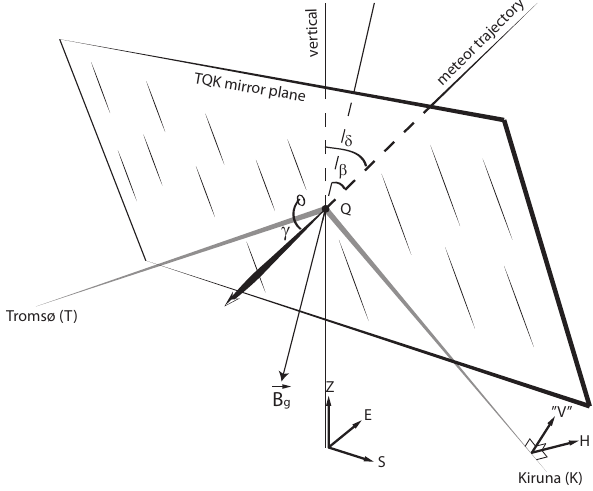
Fig. 2. Showing the relationships between the target trajectory and the most important cardinal directions, viz. the vertical, the local geomagnetic field, the T-K mirror plane and the H and “V” probes in the Kiruna antenna feed.